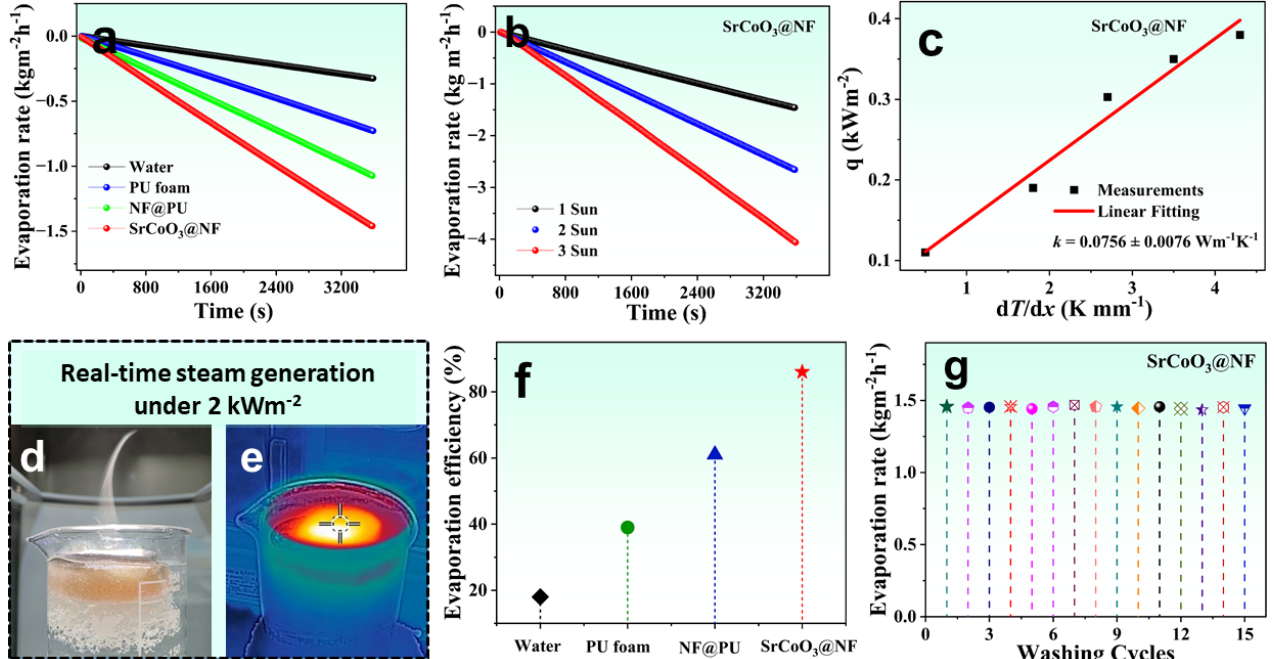
Figure 5. ( a ) Evaporation rate of four solar evaporators under 1 kW m − 2 . ( b ) Evaporation rate profile of SrCoO 3 @NF solar evaporator under multiple solar irradiations. ( c ) Thermal conductivity measurement of SrCoO 3 @NF solar evaporator. ( d , e ) Real-time demonstration of vapor generation and respective IR images under 2 sun irradiations of SrCoO 3 @NF solar evaporator. ( f ) Comparative solar-to-vapor conversion efficiencies of four evaporating systems. ( g ) Number of washing cycles vs. evaporation rate of SrCoO 3 @NF solar evaporator. Table 1. Comparison of solar-driven evaporation performance of SrCoO 3 @NF with other solar evap- orators.